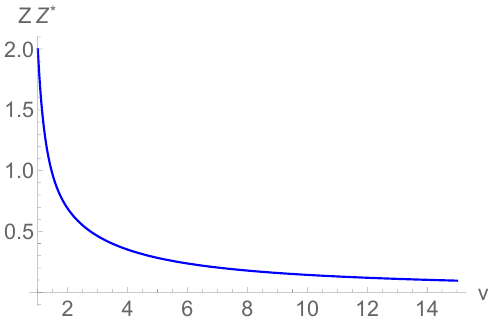
Figure 2 . The holographic Hartle-Hawking wave function in higher-spin gravity in the one- dimensional minisuperspace of anisotropic but homogeneous deformations of de Sitter coupled to a gauge (cid:12)eld, parameterized by v , for a single